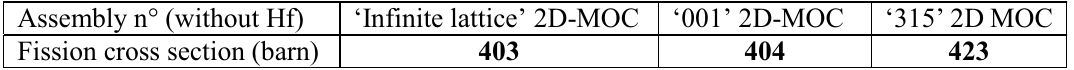
Table II. Condensed fission cross-section in group [1.0E-5eV, 1.378E-1eV] for 8 th